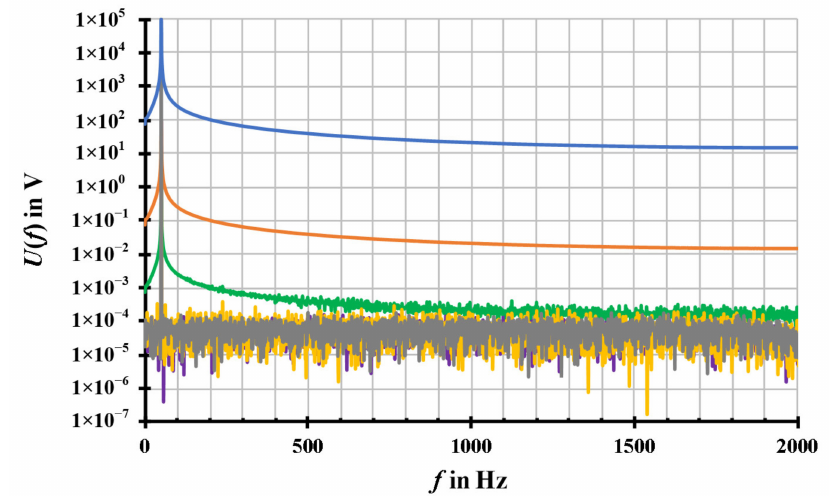
Figure 13. Full DFT spectra of three received signals from SV receiver box without resampling processing (green: U 1 = 1 V, orange: U 1 = 100 V, blue: U 1 = 100 kV) and the three corresponding resampled signals by using the modified sinc algorithm (yellow U 1 = 1 V, purple: U 1 = 100 V, grey: